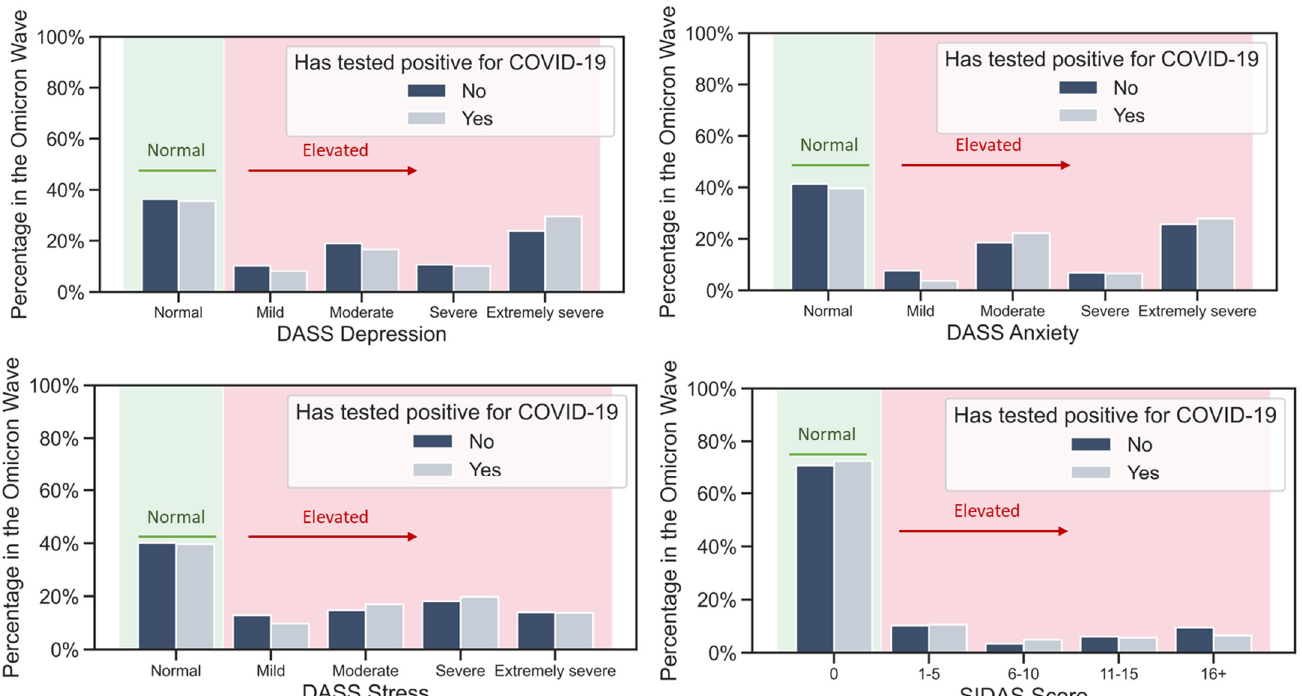
Figure 3. Distribution of DASS Depression, DASS Anxiety, DASS Stress, and SIDAS scores by category in the Omicron wave, among the respondents who had and the respondents who had not tested positive for COVID-19. The lack of differences between distributions indicates that a positive test for COVID-19 was not the reason for the observed increased scores in all the categories.